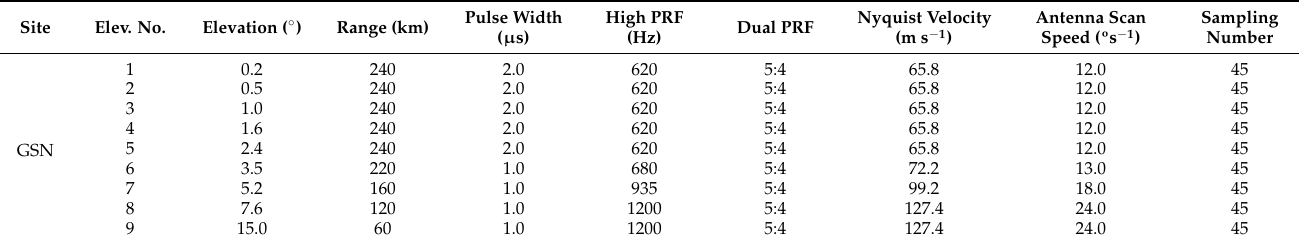
Table 2. Scan strategy of GSN radar, which is one of KMA operational S-band dual-polarization